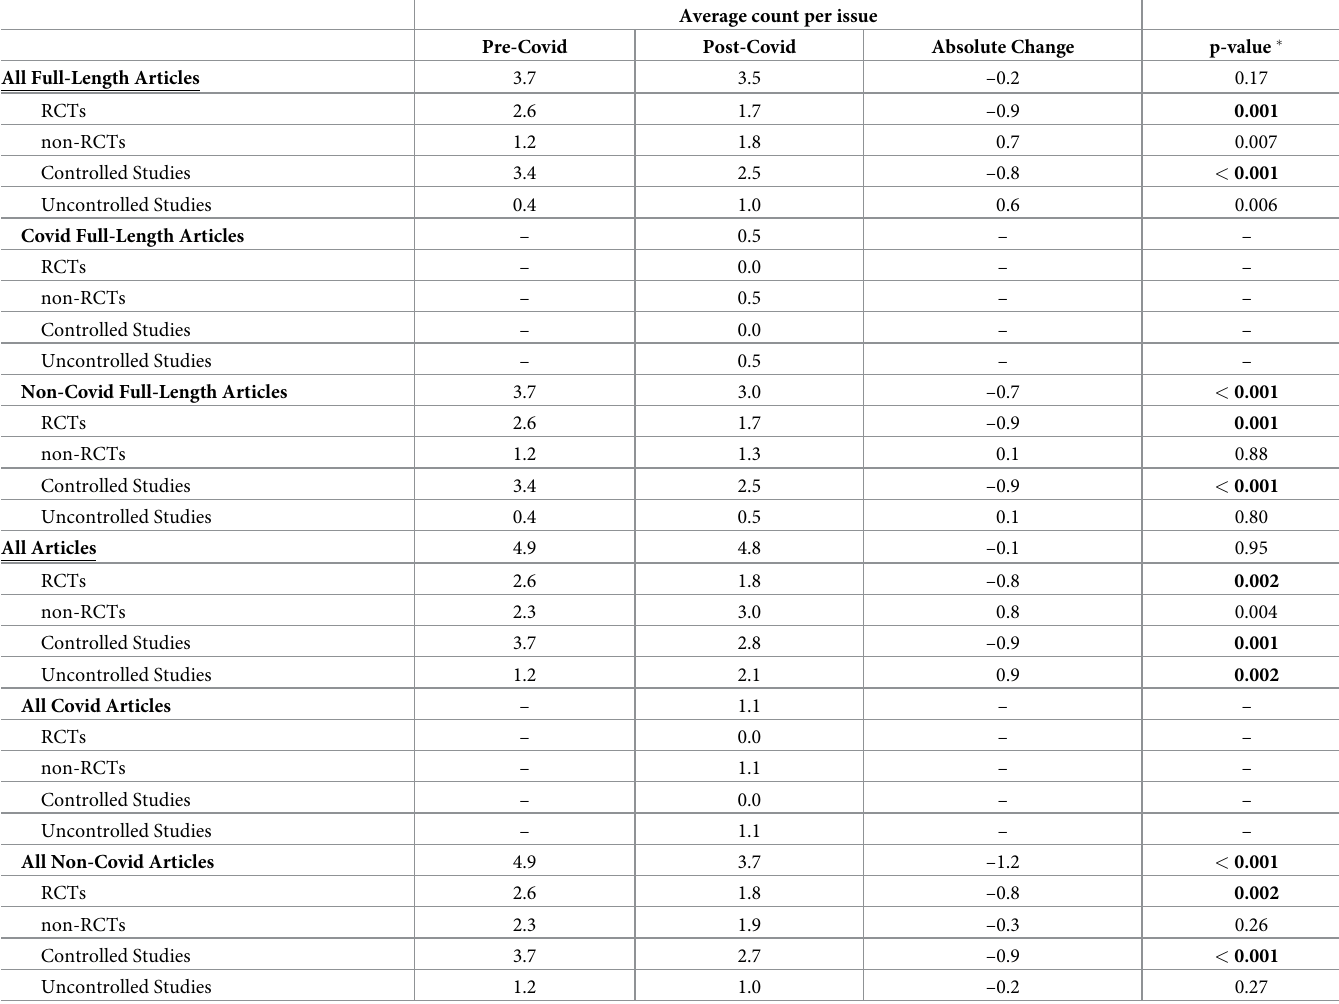
Table 3. Changes in articles per issue before and after January 31, 2020, the boundary between the defined pre- and post-Covid